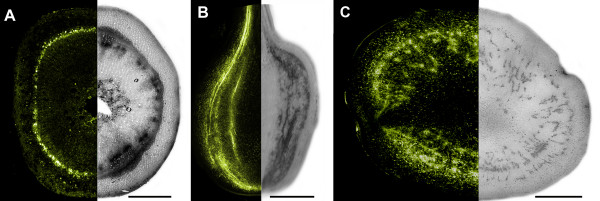
Comparison of CF and AgNO3 staining in potato tissues. Plants were labelled with aqueous CFDA and left to translocate for 5 h prior to harvesting. Tubers or stems were hand sectioned and sections were either incubated in mineral oil and examined under a confocal microscope for CF fluorescence or stained for AsA using ethanolic AgNO3. Confocal images are shown on the left and silver stained sections on the right of each panel. A, stem (bar = 2 mm); B, developing tuber (bar = 3 mm); C, large developing tuber (bar = 5 mm).